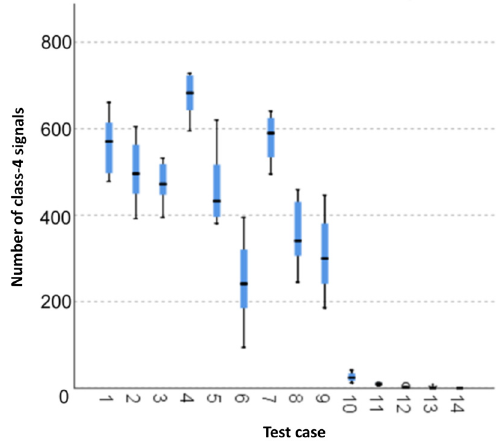
Figure 11. Graphic presentation of the Kruskal–Wallis test results for independent samples: number of class-4 signals.